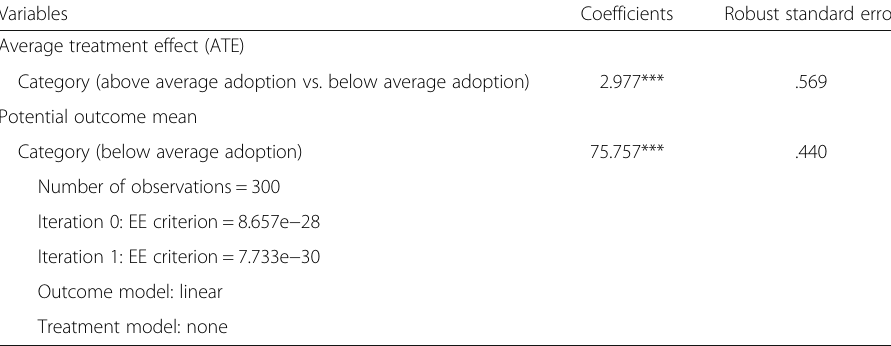
Table 5 Average treatment effect (ATE) on farmers ’ livelihoods Variables Coefficients Robust standard error Average treatment effect (ATE) Category (above average adoption vs. below average adoption) 2.977*** .569 Potential outcome mean Category (below average adoption) 75.757***